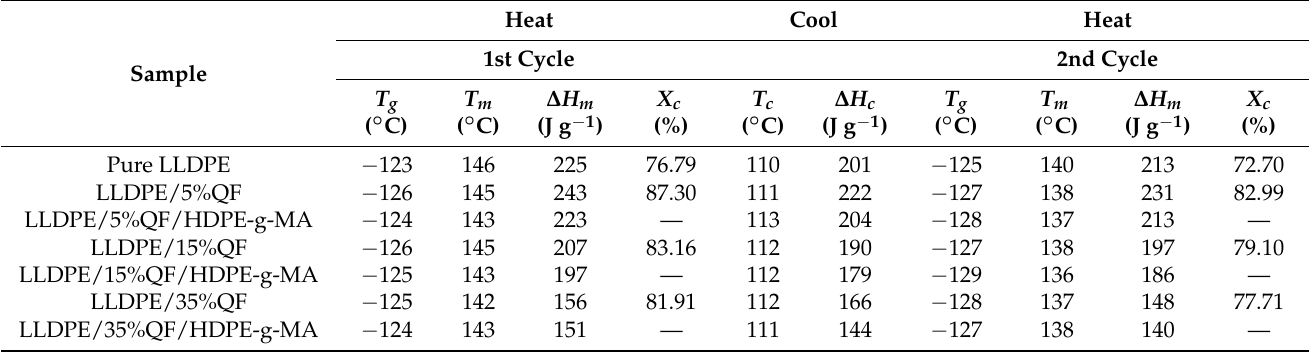
Table 2. Calorimetric measurement characteristic data for LLDPE/QF